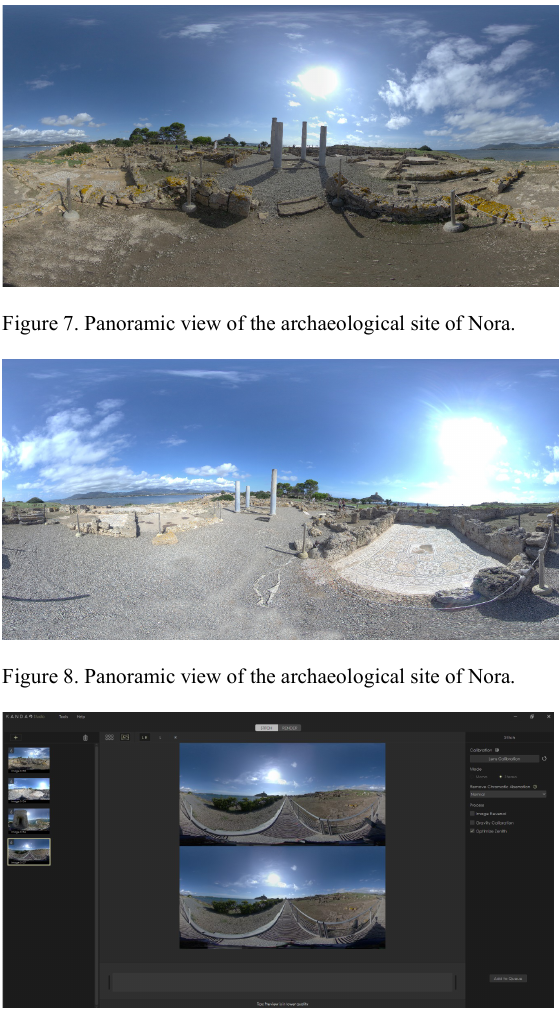
Figure 6. Panoramic view of the archaeological site of Nora.